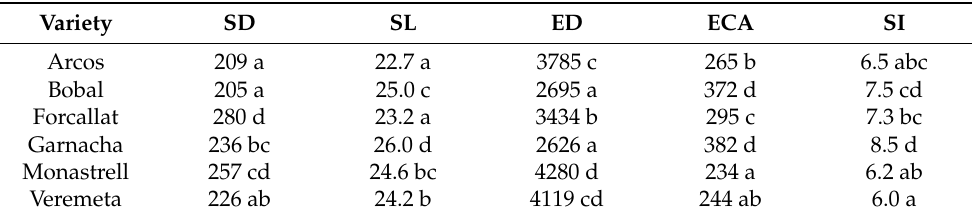
Table 5. Anatomical and morphological characteristics of stomatal and epidermal cells from Arcos, Bobal, Forcallat, Garnacha, Monastrell, and Veremeta